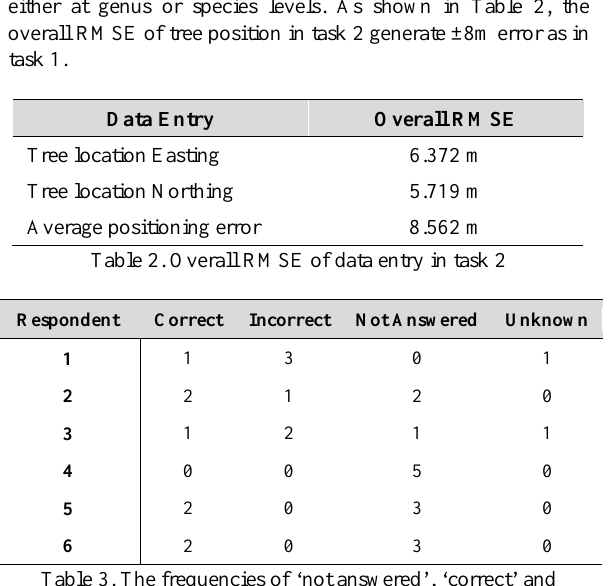
Table 4. Demographic of respondents by groups